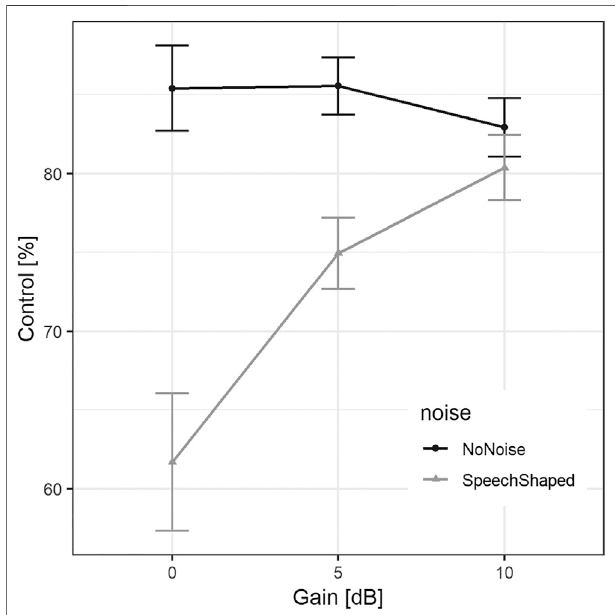
FIGURE 4 | Mean self-reported vocal control in % across participants per gain level. The error bars indicate ± standard error.